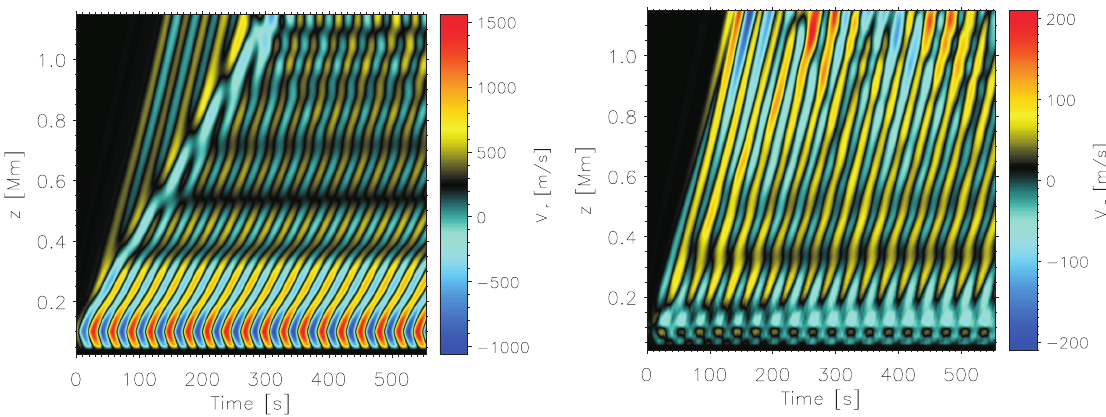
Fig. 4. The time-distance diagrams of the radial ( V r ) and the vertical ( V z ) components of the velocity at x = 0 . 98Mm and y = 0 . 98Mm, i.e., near the axis of the magnetic flux